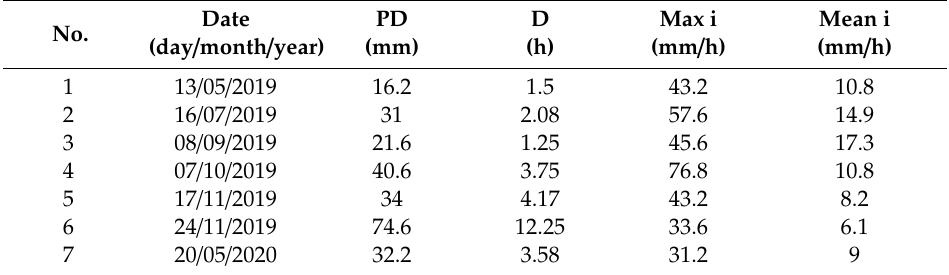
Figure 4. Rainfall characteristics for the 12-month data series (54 measured rainfall data between May 2019 and May 2020) compared with the intensity–duration–frequency (IDF) return period curves estimated for Paola (CS). Table 2. Rainfall events for